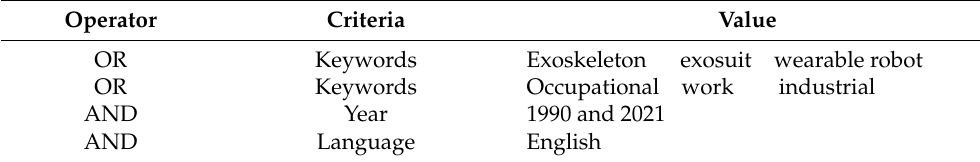
Table 1. Search criteria for the systematic